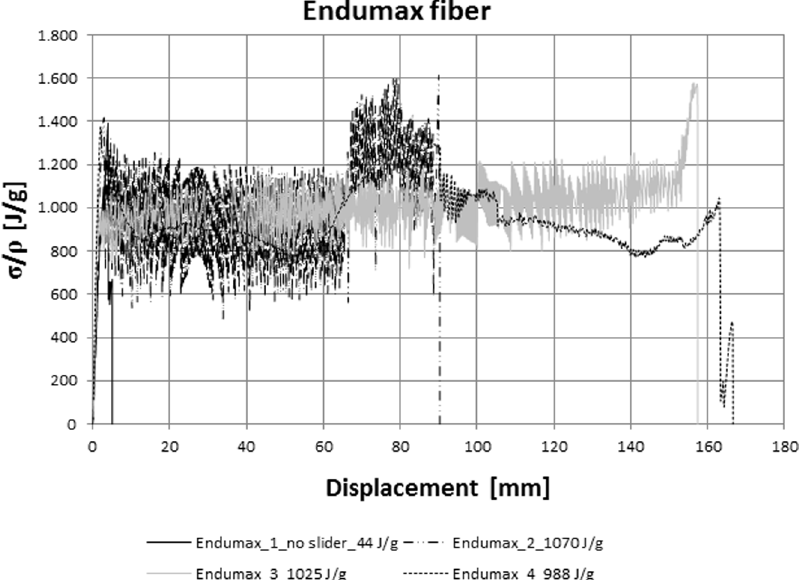
Figure 3. World toughness record (work in progress, with a zylon microfiber we have already achieved a toughness modulus of 1400 J/g starting from its intrinsic value of 20 J/g - preliminary results reported in the ERC proposal ‘‘Knotough’’). Force vs displacement curve of Endumax fibres with (samples 2,3,4) or without a slider (sample 4). The pristine fibre has a toughness modulus of 44 J/g. The introduction of the slider dramatically changes the scenario: a long plastic-like plateau clearly emerges thanks the presence of the slider and allows the dissipation of a huge amount of energy, approaching an unprecedented toughness modulus of 1070 J/g (other two tests, leading to 988 and 1025 J/g are shown). The specific strength and thus maximal achievable toughness is for this fibre of about 1600 J/g (see stress peak in the figure).